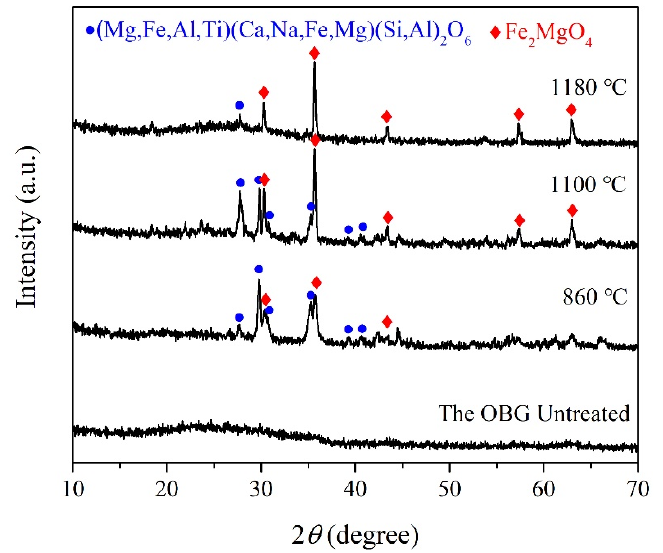
Figure 5. XRD patterns of the olivine basalt glass heat-treated at different crystallization temperatures.